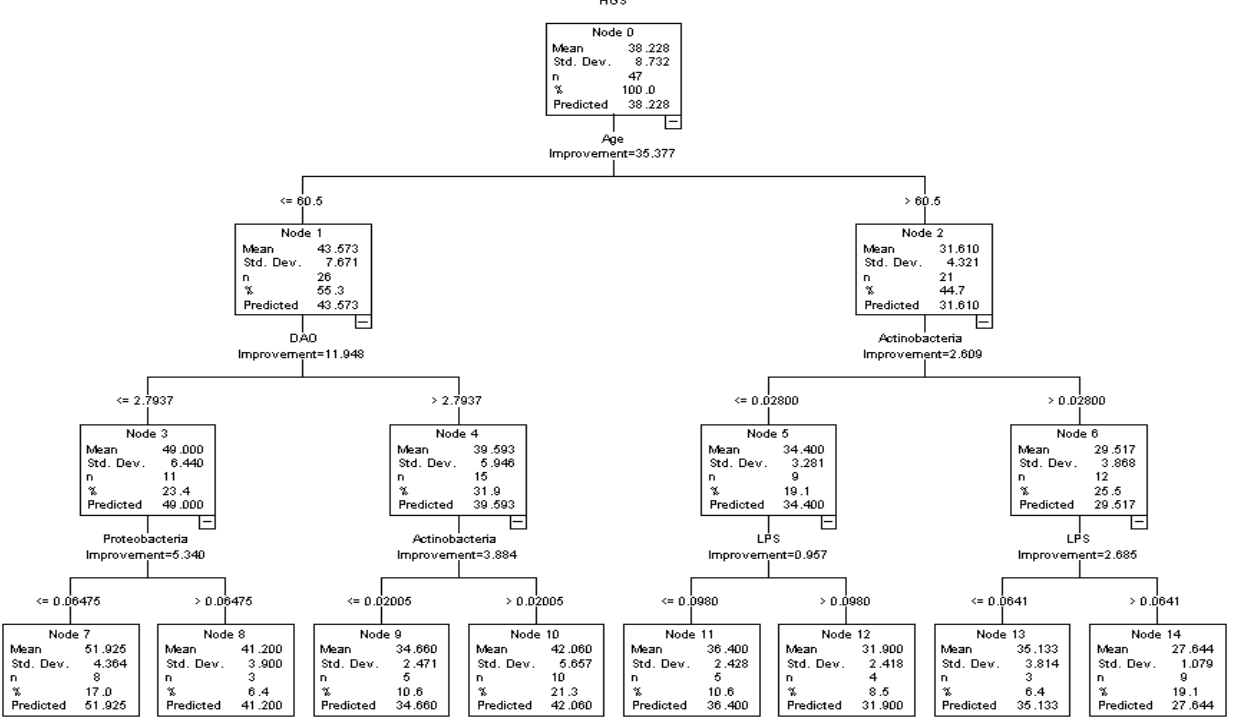
Figure 1. Associations among intestinal permeability, GM and HGS in middle-aged and older males in the decision tree model.